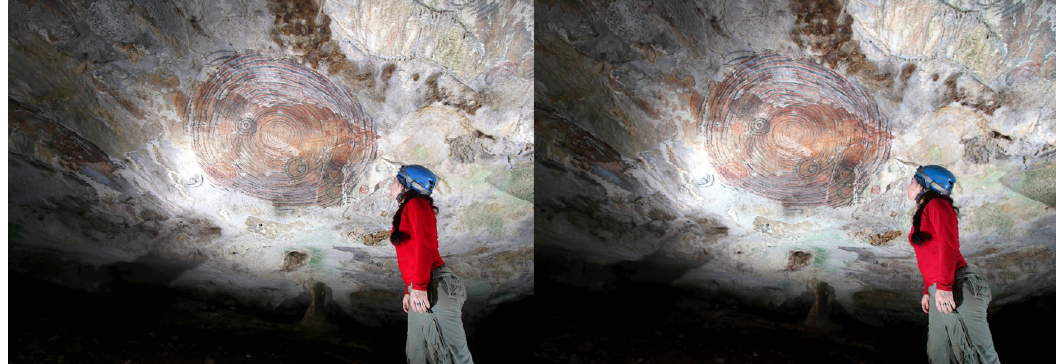
Figure 9: Stereoscopic images of the central pictogram of Punta del Este used for 3D short movies ( slides )